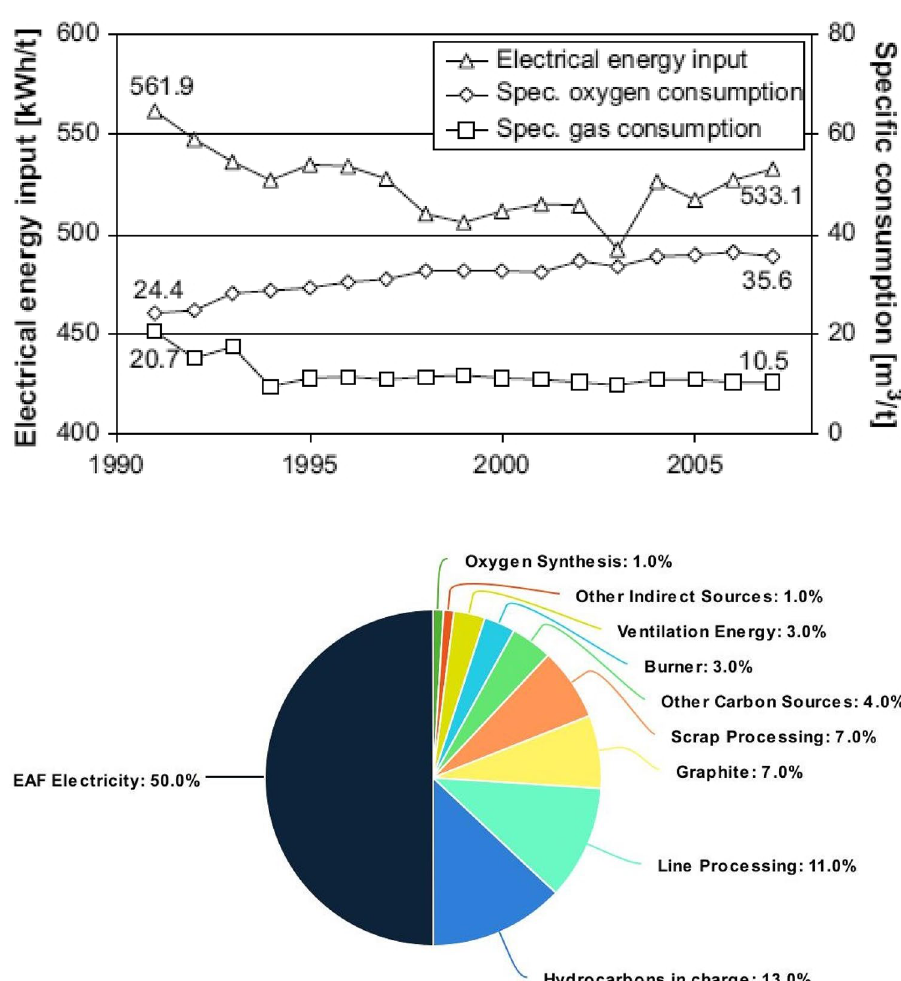
Fig. 7 Mean specific electri- cal energy input and specific consumption of oxygen and natural gas in EAF steel plants